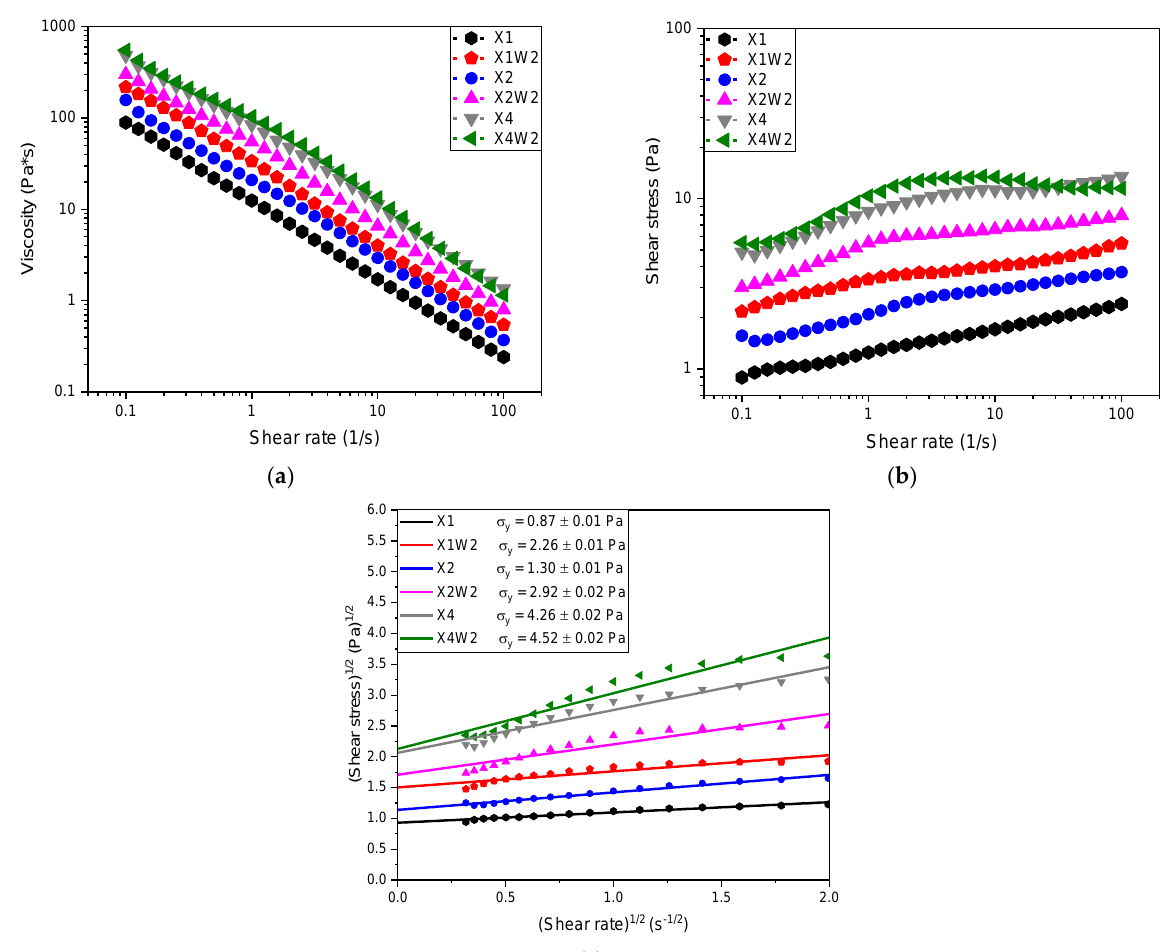
Figure 1. Rheological tests on the hydrogel composites. Trends of ( a ) shear viscosity and ( b ) shear stress as a function of the shear rate. ( c ) Linear interpolation of shear stress values for the determi- nation of the yield stress, according to the Casson model (see Equation (1)).